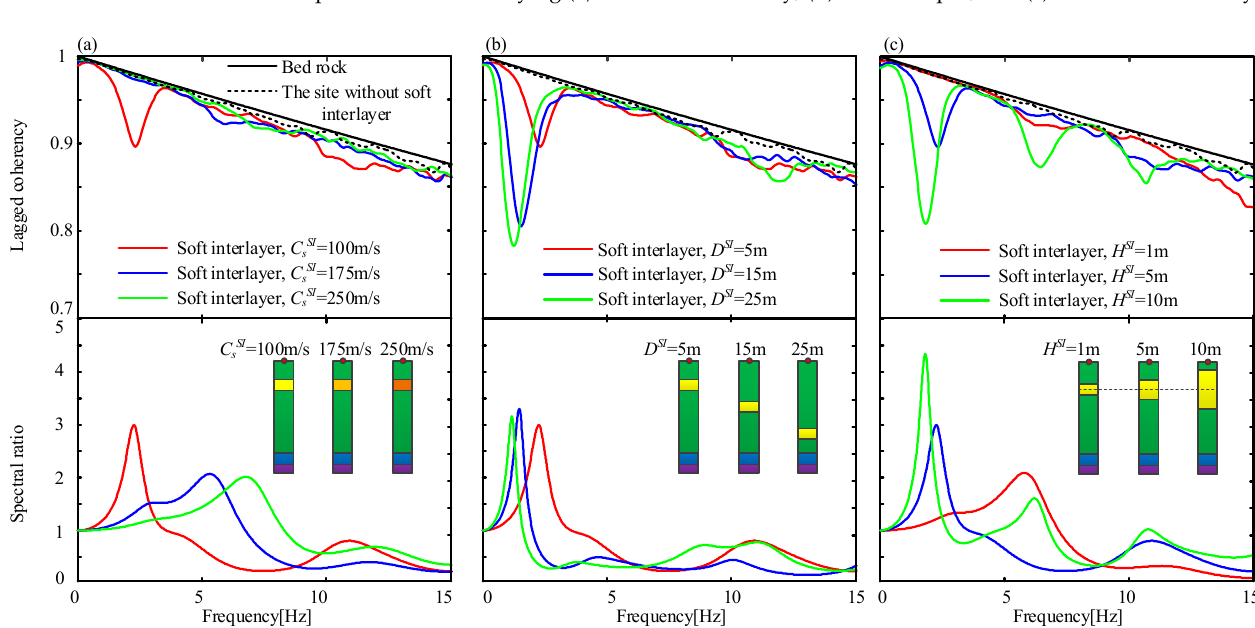
Figure 5. Mean lagged coherency between horizontal in-plane motions and corresponding spectral ratios for varying ( a ) shear wave velocity; ( b ) buried depth; and ( c ) thickness of interlayer.